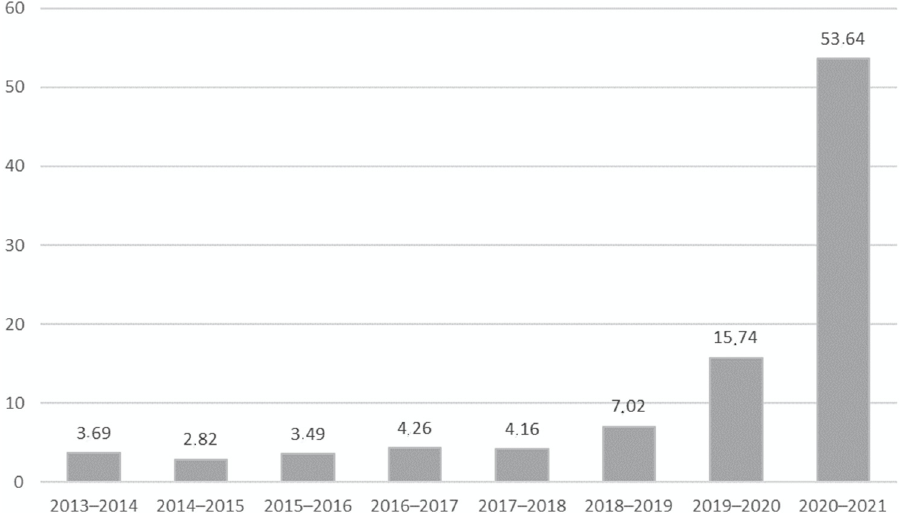
Figure 1. Number of vaccinated HCWs from 2013–2014 influenza season to